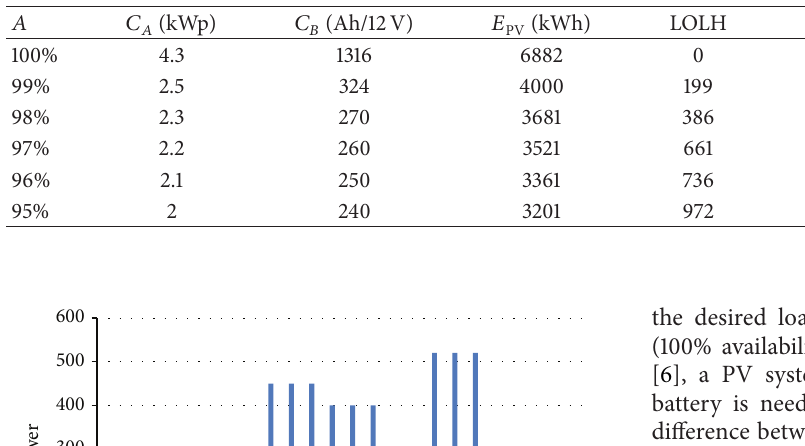
Table 1: Designed PV systems specification.